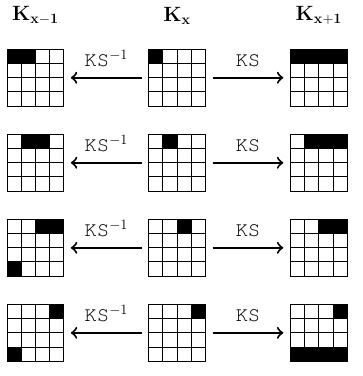
Figure 5: Backward/forward truncated differential transitions through the AES-128 key schedule when only a single byte is active in K x . All these patterns are invariant by rotation along the columns. The black/white cells represent active/inactive bytes.